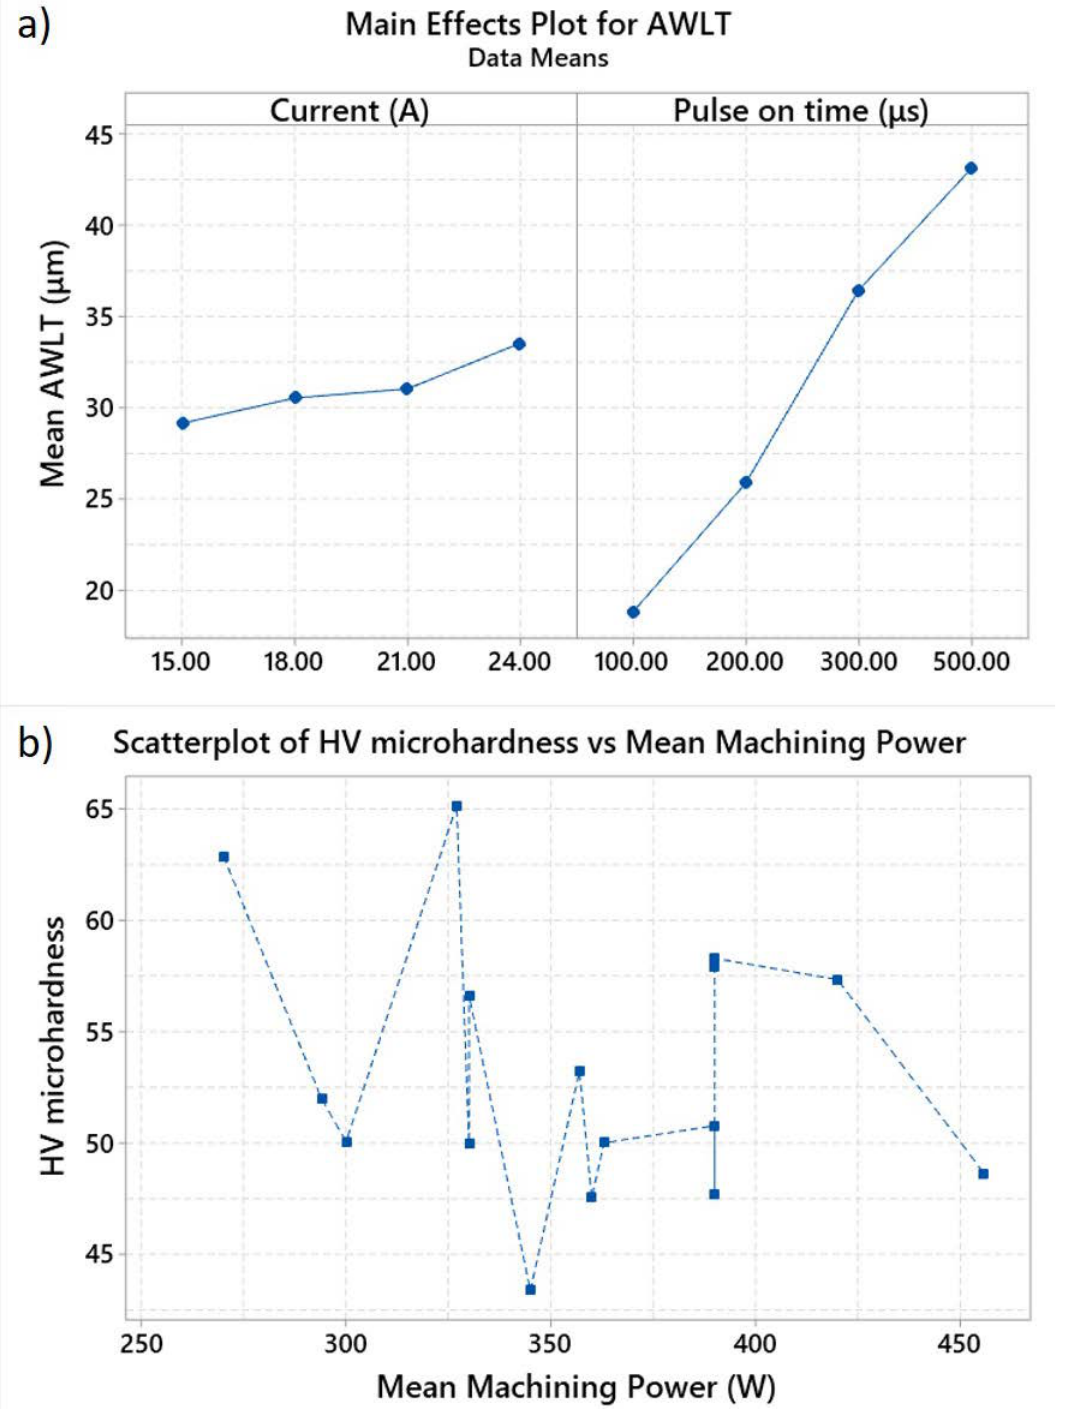
Figure 7. ( a ) Main effect plot for AWLT. ( b ) Scatterplot of micro-hardness HV vs. mean machining power.